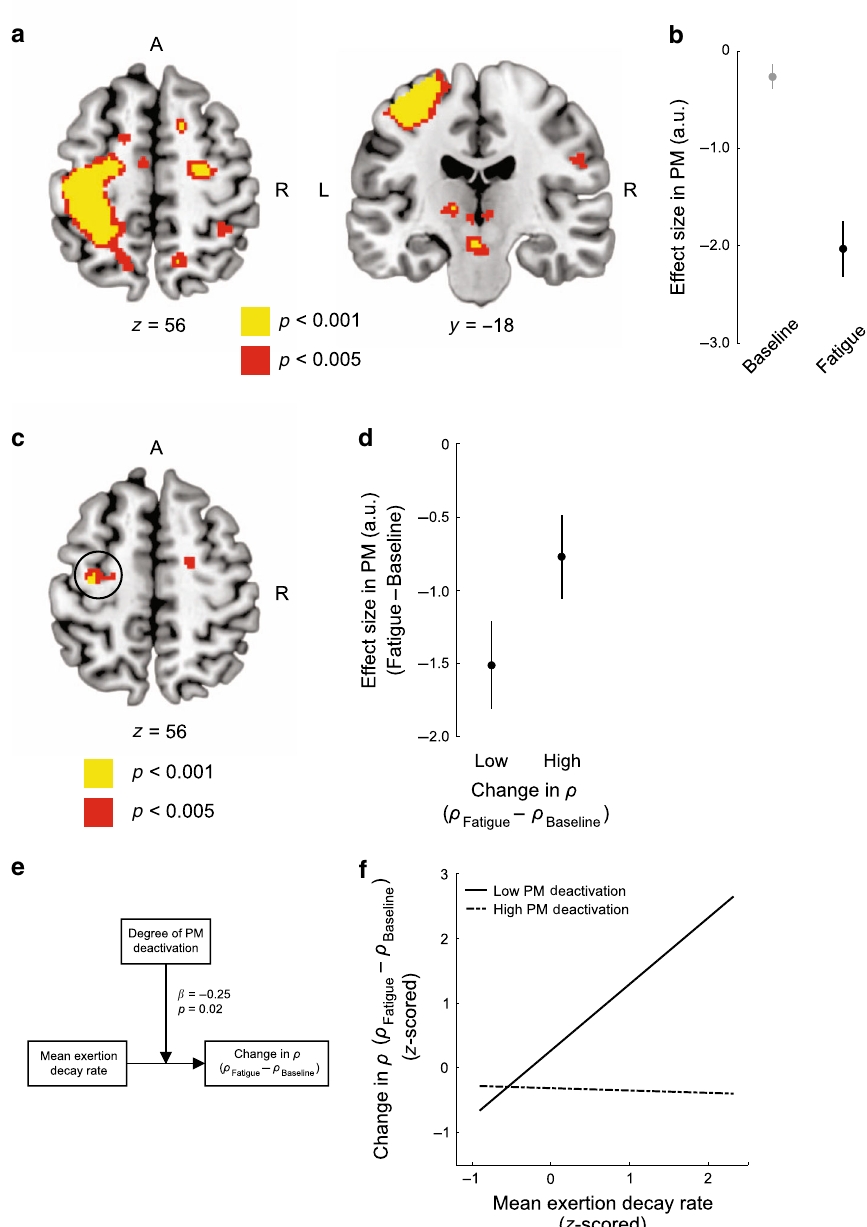
Fig. 4 Neural signatures of exertion-induced fatigue ( n = 20). a Exertion-induced changes in brain activity. Whole brain results thresholded at voxelwise p < 0.005 (red) and p < 0.001 (yellow). Activity in primary motor cortex (peak = [ − 38, − 30, 52]) and PM (peak = [ − 36, − 18, 54]) was reduced in the fatigue condition, relative to baseline, at the time of choice. These activations are signi fi cant small-volume corrected p < 0.05 within our a priori premotor ROI. b Illustration of the PM (5 mm sphere centered at [ − 36, − 18, 54]) effects reported in ( a ). This plot was not used for statistical inference, which was performed in the SPM framework. Error bars indicate SEM. c Bold signal in PM is positively modulated by fatigue-induced increases in ρ fatigue relative to ρ ρ – ρ baseline . Between-participant regression analysis entering the change in effort subjectivity fatigue baseline as a covariate for the decreasing activity between the fatigue and baseline choice phases in PM (peak = [ − 32, − 14, 58]; small volume corrected p < 0.05 in a priori ROI). d Relationship between activity in PM (5 mm sphere centered at [ − 32, − 14, 58]) and the degree of fatigue-induced change in effort subjectivity parameters. The low/high groups are de fi ned by the median split of the change in ρ metric. Individuals who exhibit greater fatigue-induced increases in the subjective effort parameters have less PM deactivation. This plot is shown solely to illustrate the pattern of the BOLD signal and statistical inference was performed in the SPM framework. Error bars indicate SEM. e Moderation analysis. We tested the extent to which changes in PM activity moderates the relationship between exertion-induced decreases in effort capacity (indexed by mean exertion decay rate parameters) and changes in subjective effort value (indexed by ρ fatigue – ρ baseline ). f Illustrative plot of the moderating in fl uence of PM deactivation on the relationship between fatigue-induced reduction in motor performance and increases in the subjective cost of effort. The lines represent regressions between mean exertion decay and fatigue-induced changes in ρ , separated by median split PM activity. The less PM deactivation between the baseline and fatigue phases, the stronger the relationship between the fatigue-induced decay in motor performance and fatigue-induced increases in the subjective cost of